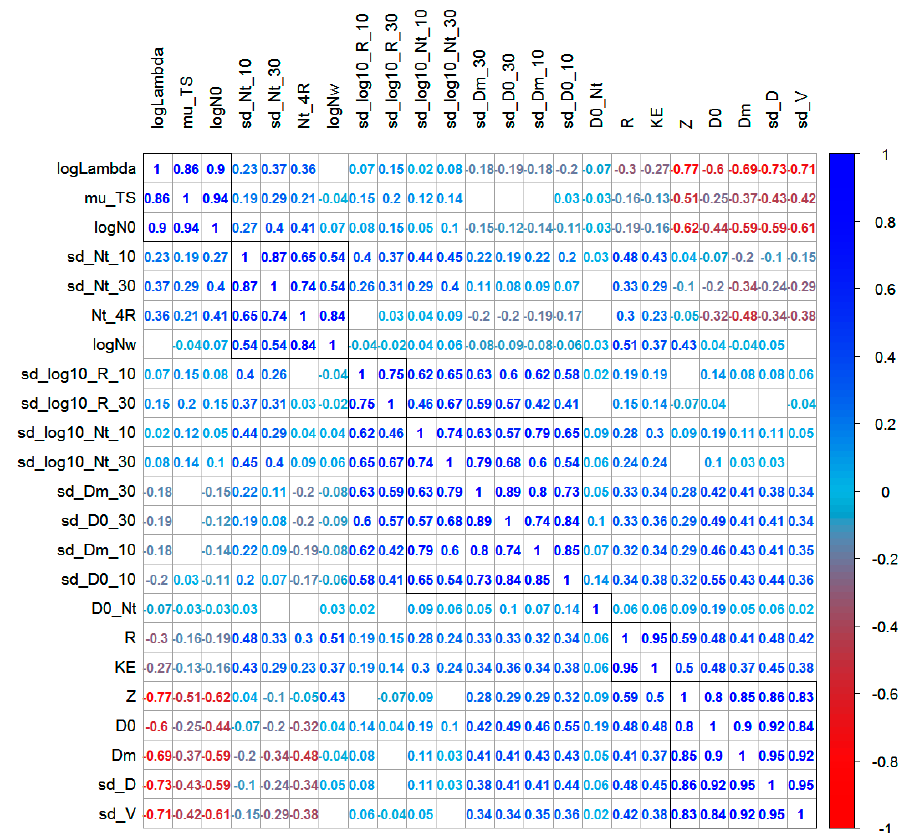
Figure 4. Correlation matrix of the rain microstructure parameters. Blank cells represent insignificant correlation with confidence level of 0.95.